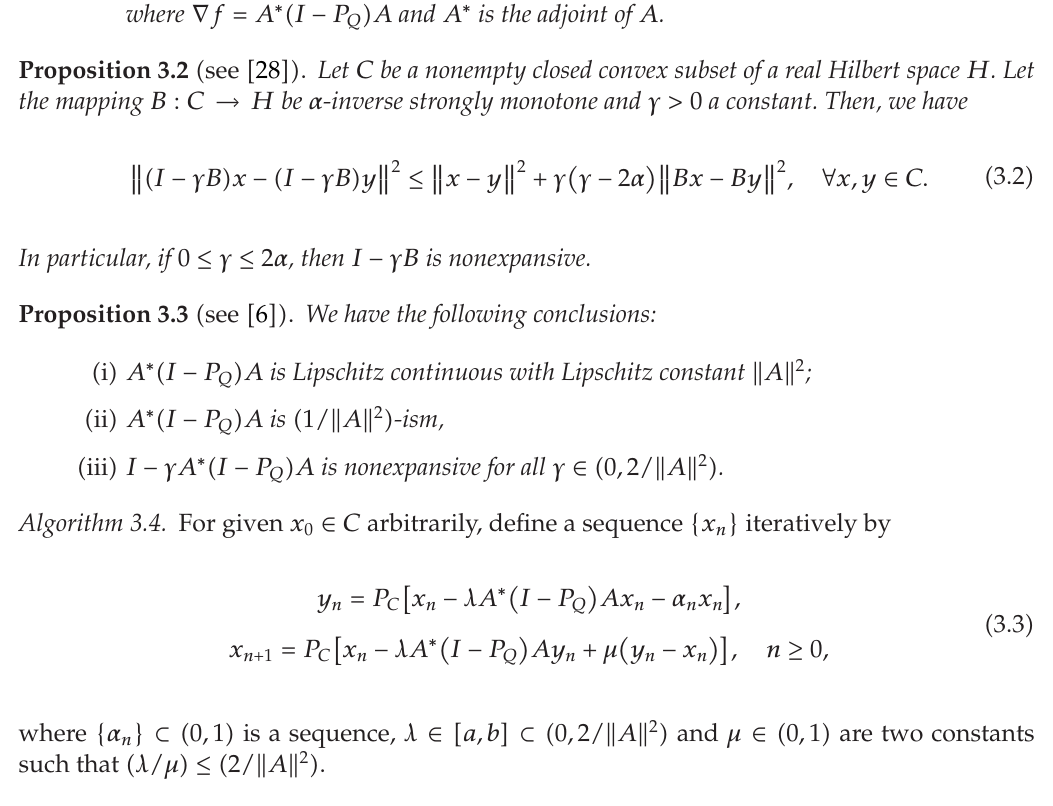
Algorithm 3.4. For given x 0 ∈ C arbitrarily, define a sequence { x n } iteratively